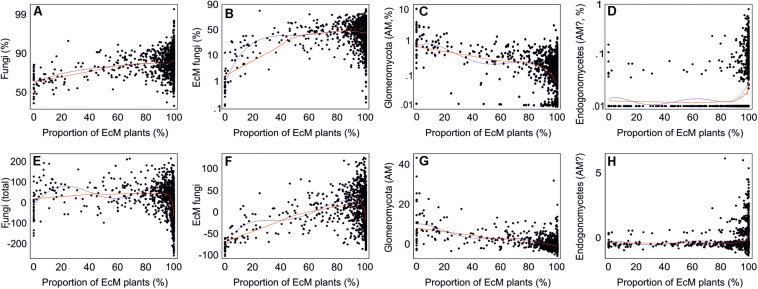
Relationships between the proportion of ectomycorrhizal plants and proportion of (A–D) sequences (log-ratio scale) or (E–H) OTUs (residuals) of all fungi and mycorrhizal fungi. Blue and red lines indicate best-fitting quadratic polynomial and lowess regression lines, respectively.